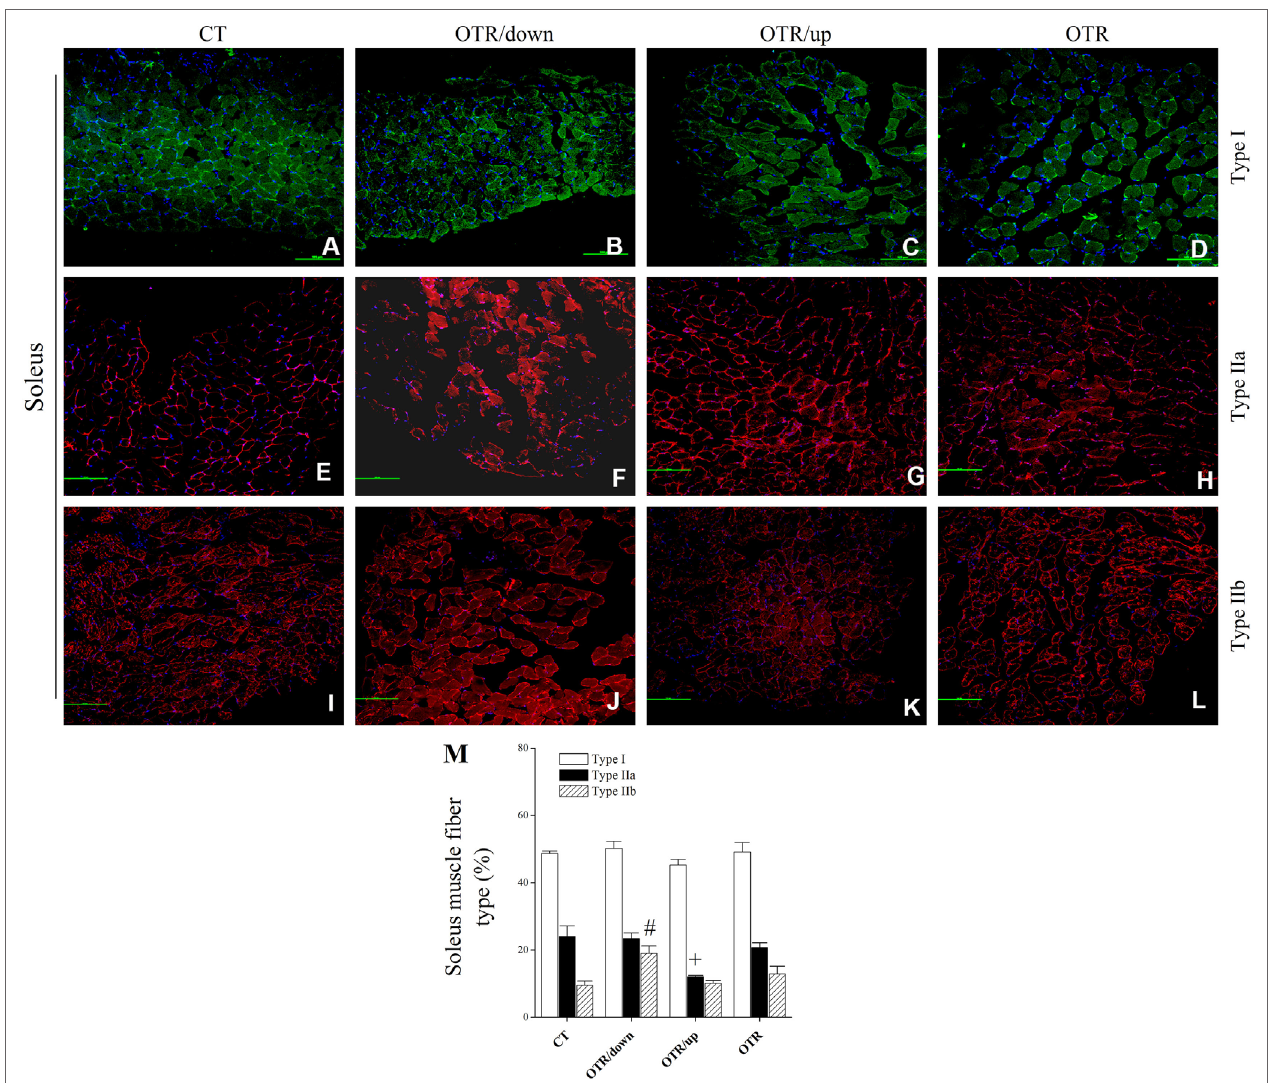
FigUre 5 | Representative immunofluorescence images of soleus muscle fiber type composition from control (CT) [ (a) type I, (e) type IIa, and (i) type IIb], downhill running-based overtraining (OTR/down) [ (B) type I, (F) type IIa, and (J) type IIb], OTR/up [ (c) type I, (g) type IIa, and (K) type IIb], and OTR [ (D) type I, (h) type IIa, and (l) type IIb]. Percentage of type I, type IIa, and type IIb (M) fibers in soleus muscle. Data correspond to n = 4 mice. CT: sedentary mice. OTR/down: overtrained by downhill running. OTR/up: overtrained by uphill running. OTR: overtrained by running without inclination. + P < 0.05 vs. CT, OTR/down, and OTR; # P < 0.05 vs. CT, OTR/up, and